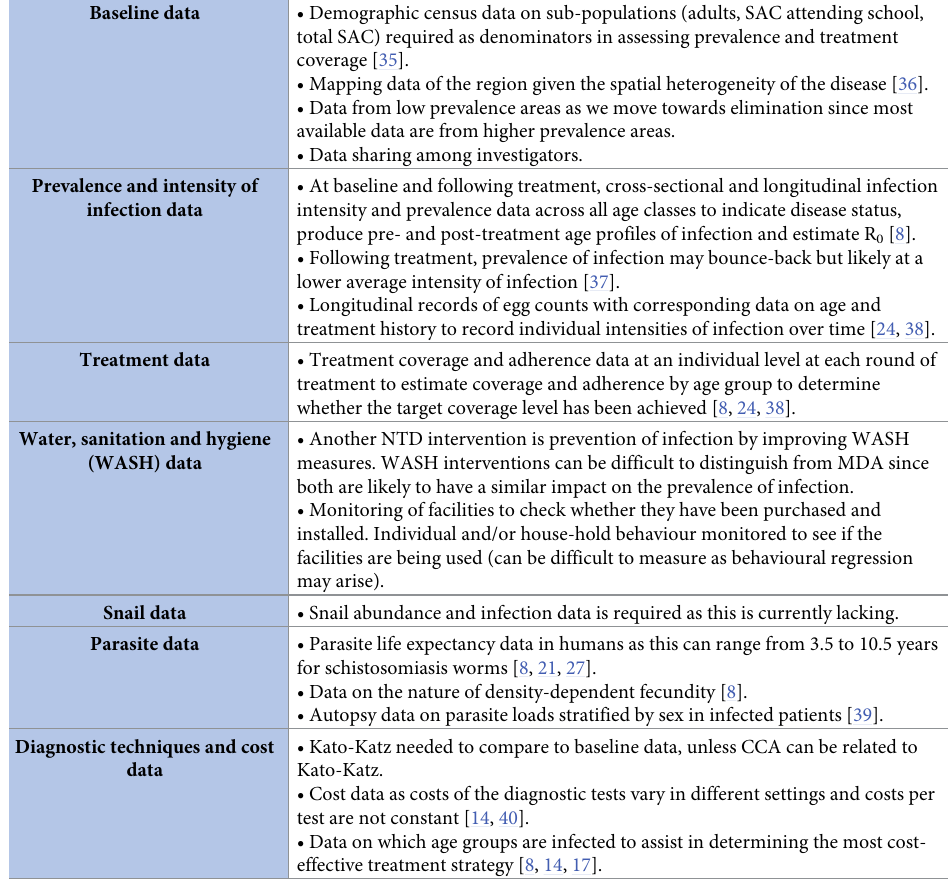
Table 2. Data requirements for monitoring and evaluation (M&E)